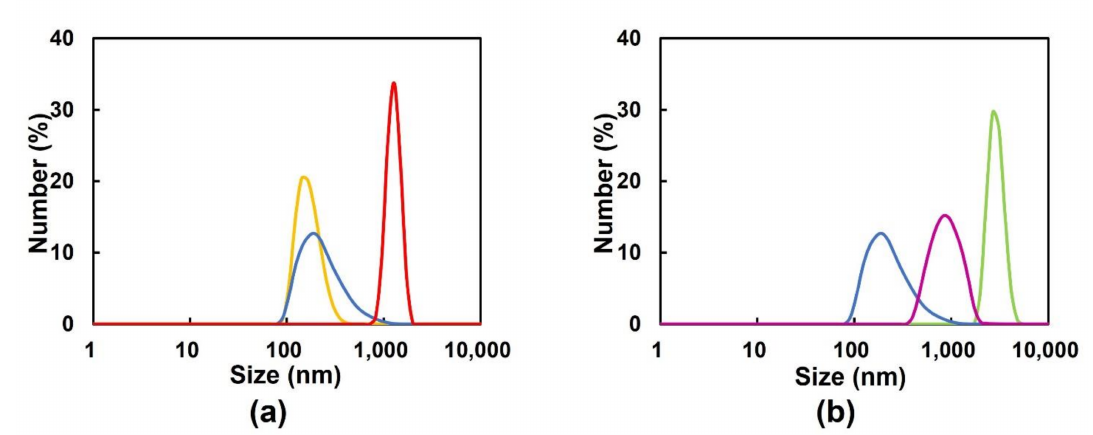
Figure 5. Confirmation of particle size of BSA-PNIPAAm conjugates by DLS at 35 ◦ C. ( a ) Monomer ratio to CTA. B/C5/PN400 (yellow), B/C5/PN800 (blue), B/C5/PN1600 (red). ( b ) CTA ratio to BSA. B/C2/PN800 (green), B/C5/PN800 (blue), B/C10/PN800